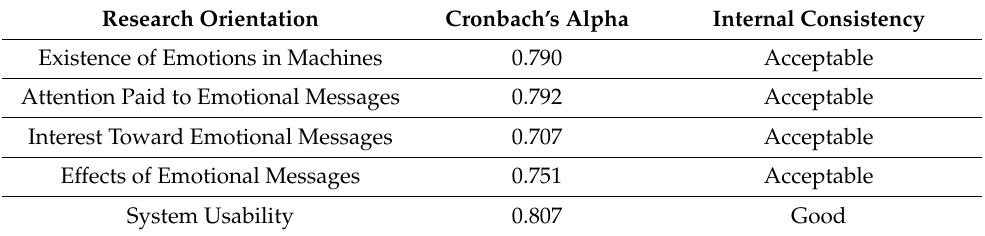
Table 5. Reliability of different aspects of the research questionnaire.